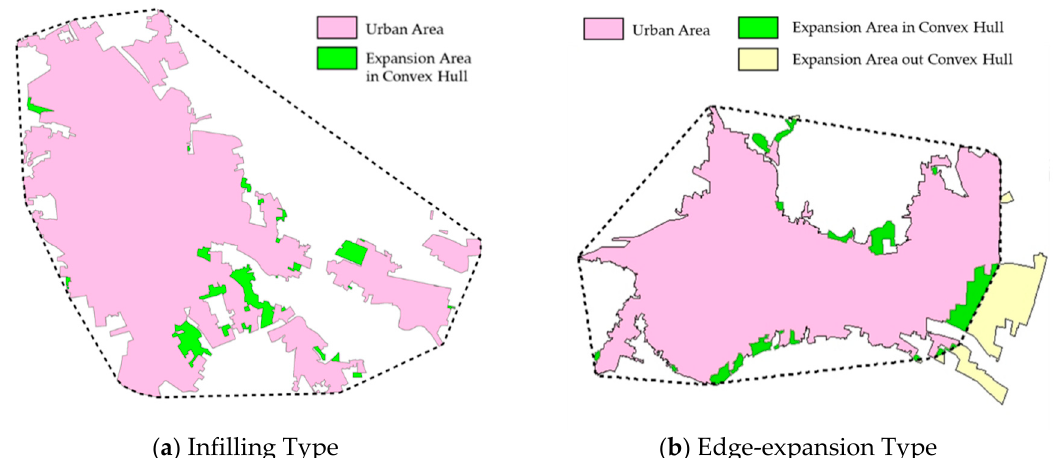
Figure 4. Examples for urban expansion types.